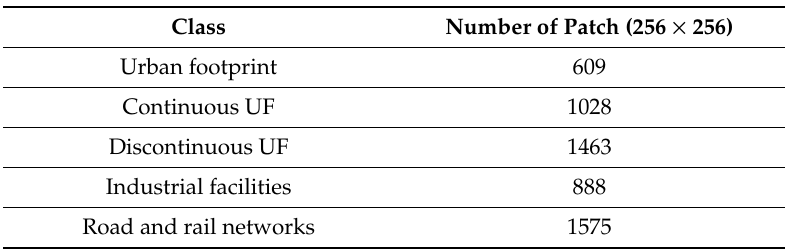
Table 4. Dataset size per UF class.